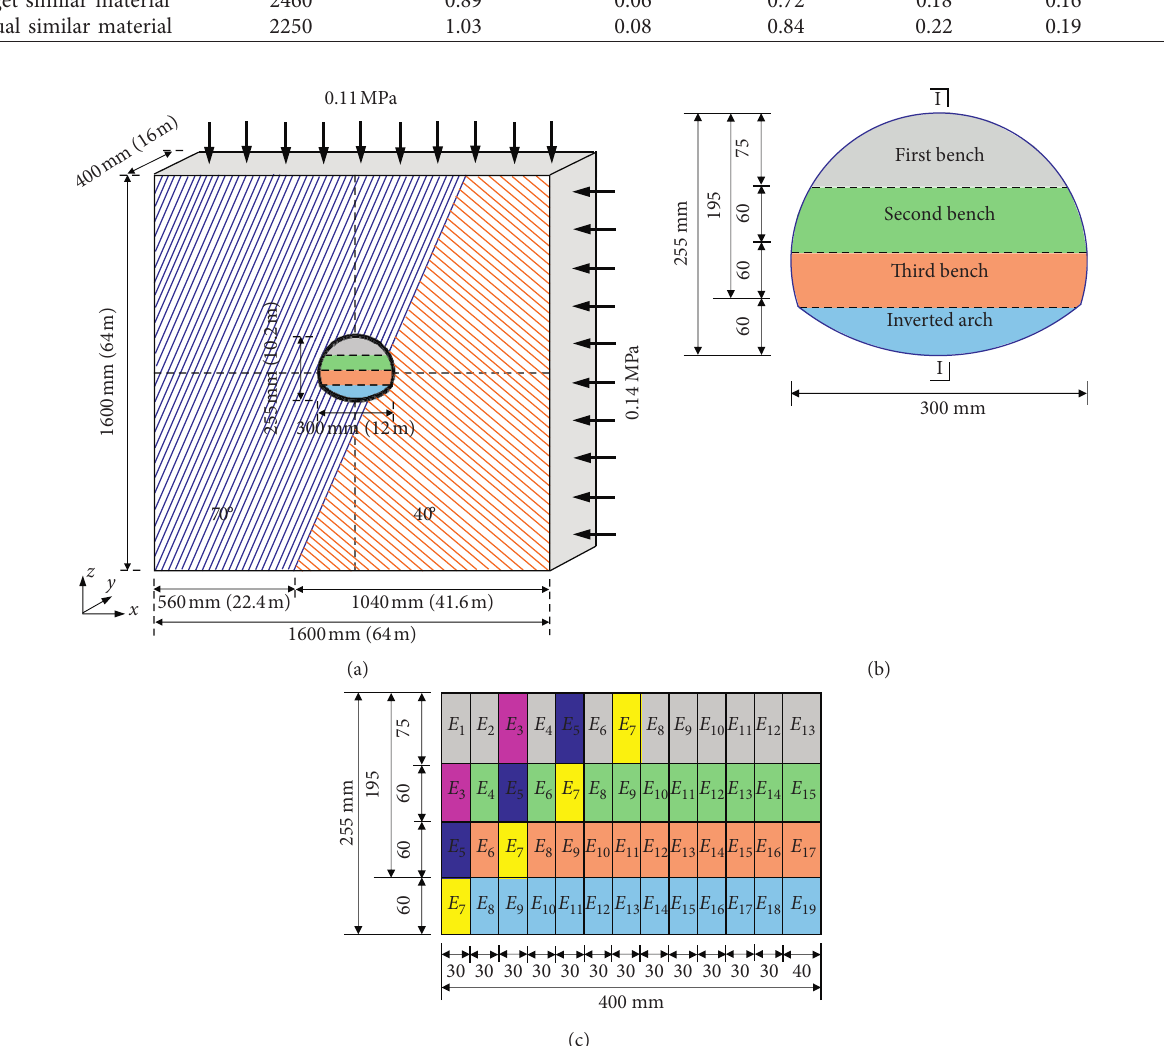
Figure 5: Physical model design: (a) layout of physical model, (b) three-bench tunnelling method in the tunnel face, and (c) tunnelling footage and steps (II-I